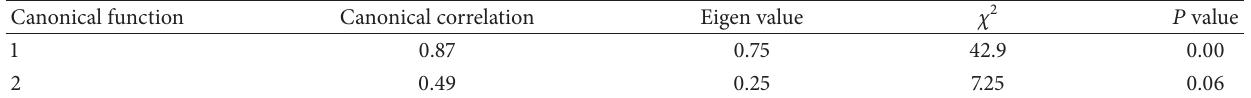
Table 6: Summary result of canonical correlation analysis relating soil properties and earthworm population characteristics. (a) Measures of overall model fit for canonical correlation